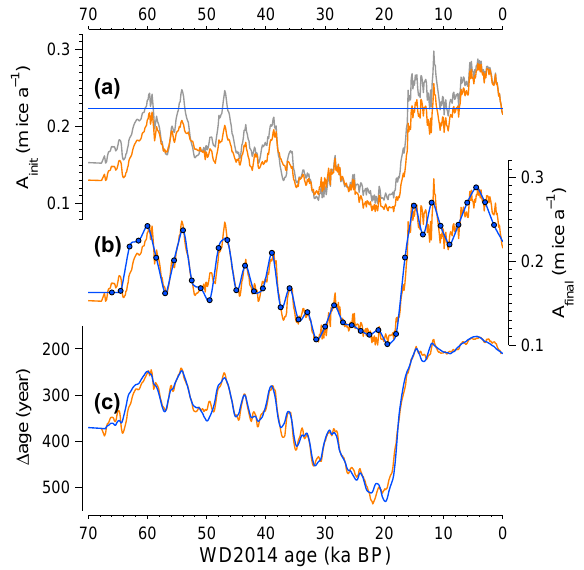
Figure 2. Reconstructing A(t) and (cid:49) age from δ 15 N: the choice of accumulation template. (a) A init (t) based on λ(z) from the annual- layer count (0–31.2kaBP) and Clausius–Clapeyron scaling of wa- ter stable isotope data (34.2–68ka) in orange; A init = 0 . 22ma − 1 in blue; and for comparison the final A(t) solution (Fig. 1b) in grey. For the orange curve we have used the Nye thinning func- tion (Fig. 1e); the final ice-flow model optimizes the agreement be- tween A(t) obtained from λ(z) and from the inverse firn modeling approach. The WD2014 chronology uses the orange A init (t) sce- nario. (b) A(t) found in the inverse firn modeling approach using both A init (t) scenarios; color coding as in panel (a) . The function ξ(t) is found as follows. We use control points at 1500-year inter- vals (blue dots); the algorithm has the freedom to change the value of ξ(t) at each of these points. In between the control points, ξ(t) is found via linear interpolation. (c) Modeled (cid:49) age using both A init (t) scenarios; color coding as in panel (a)